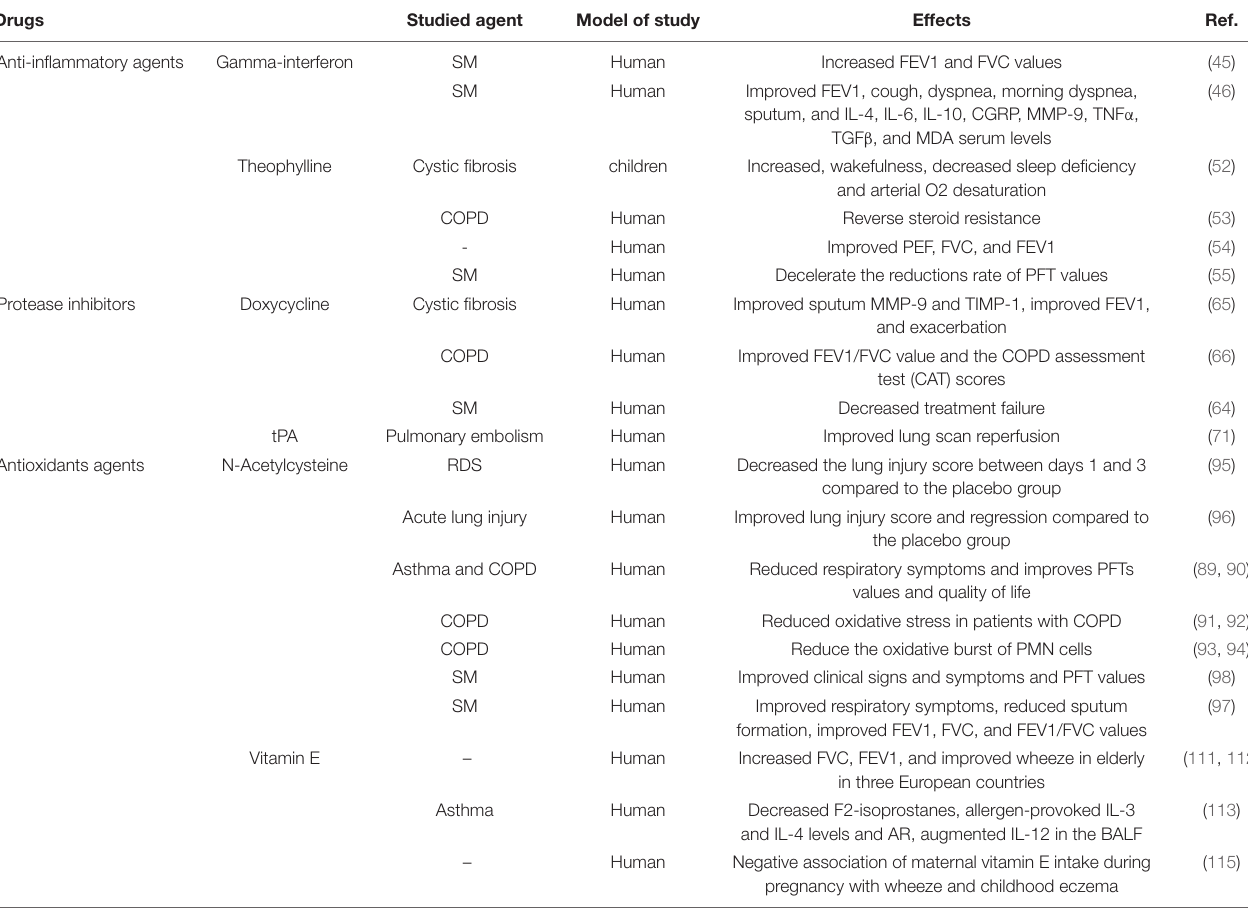
TABLE 2 | Therapeutic effects of pharmaceutical drugs on SM-induced lung injuries, clinical studies. Drugs Studied agent Model of study Effects